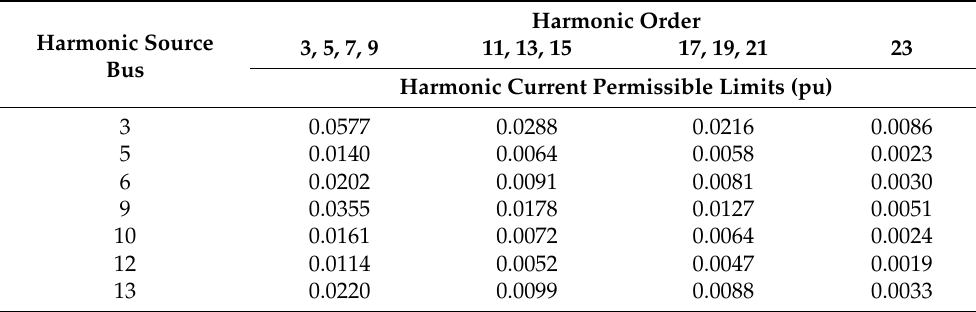
Figure 4. Modified IEEE 14 ‐ bus power system with multiple harmonic sources. Table 1. Permissible harmonic current limits (pu) for harmonic sources in IEEE 14 ‐ bus test system based on IEEE Standard 519 ‐ 2022.